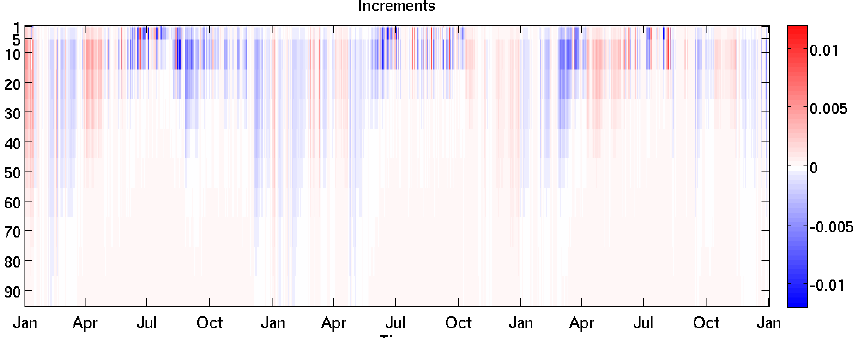
Fig. 13. Representation of daily increments (m 3 m − 3 ) provided by the SSM assimilation in DF-CDF with a per year CDF matching. Soil layer depths (in cm) are represented on the left-hand side y axis and time on the x axis.